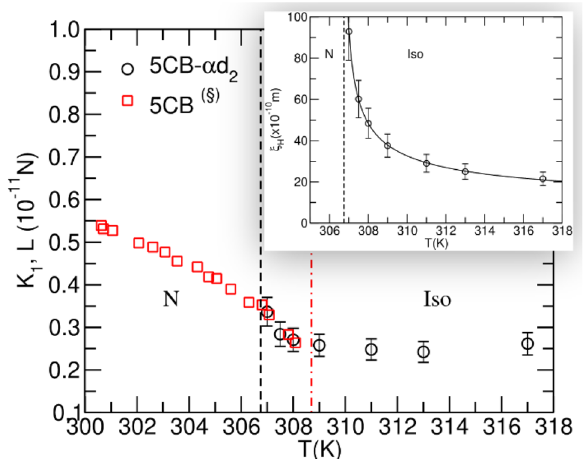
Figure 3. Values of Frank’s elastic constant K 1 for 5CB as a function of temperature. In the nematic phase (red squares) the values were obtained from Bunning et al. 30 using magneto-optic techniques to study the Fréedericksz transition. The values of rotational elasticity L in the isotropic phase (black circles) of 5CB- α d 2 were obtained from the NMR data analysis. The inset figure shows the coherence length as a function of temperature and the model fitting curve ξ H = A / (cid:31) T − T ∗ c + ξ ∞